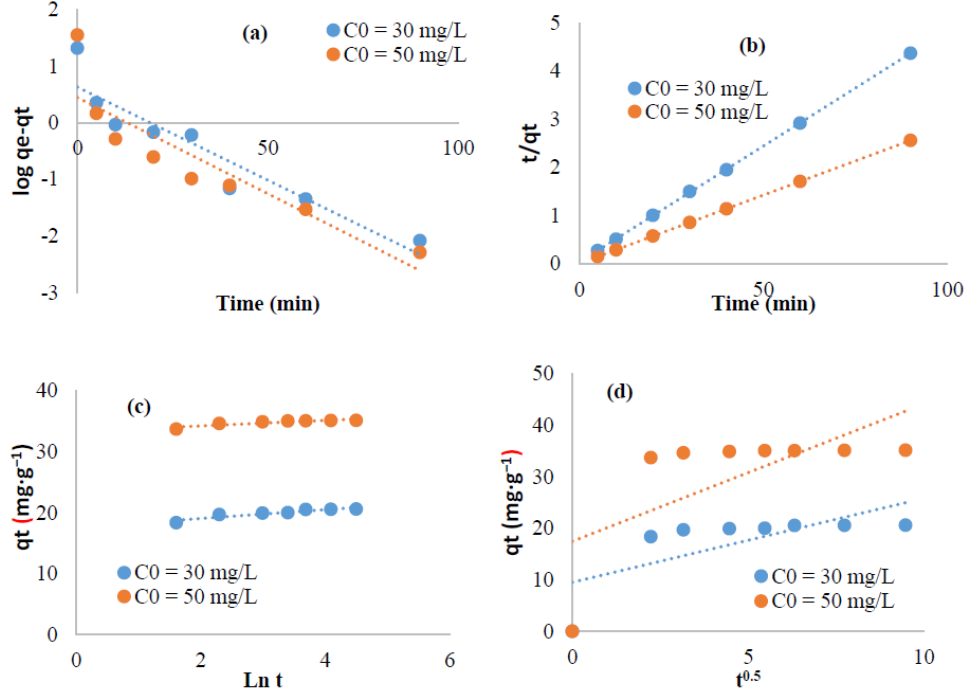
Figure 8. Linearized kinetic data for Methylene blue adsorption: ( a ) First pseudo order, ( b ) Pseudo second order, ( c ), and ( d ) Intra-particular diffusion.